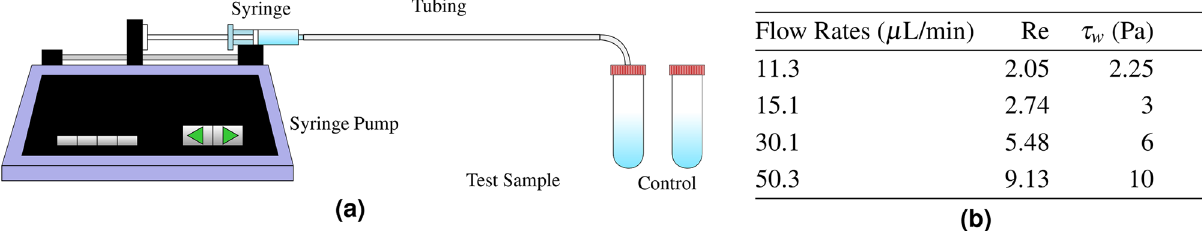
Figure 6. (a) The experimental apparatus, consisting of a syringe pump infusing cells through the tubing. Figure was created using Inkscape 31 . (b) Investigated flow rates and corresponding τ w and Reynolds numbers (Re) used in circulatory